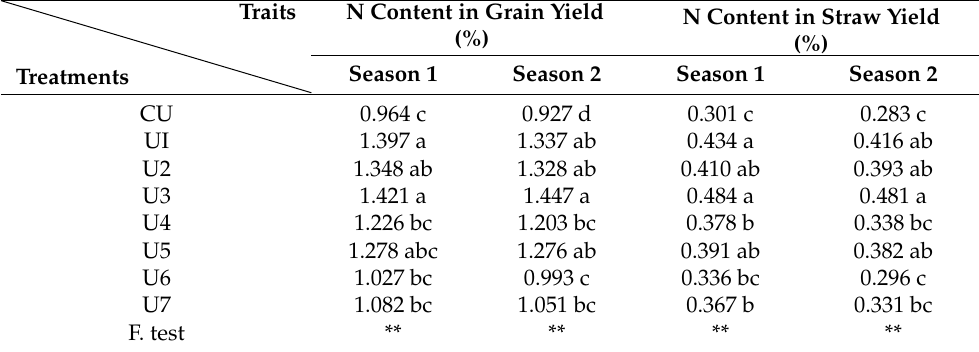
Table 8. Effects of different rates of classical urea fertilizer, urea chitosan nanohybrid and their combinations as exogenous application on N content in both grain and straw of rice during the 2020 and 2021